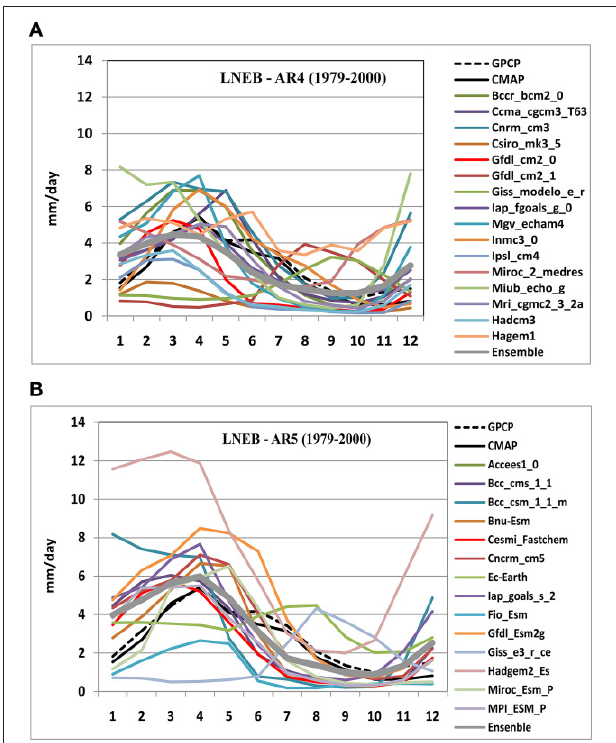
FIGURE 4 | Annual rainfall cycle observed (GPCP and CMAP) for the SNEB over the period 1979–2000 and simulated CMIP3-AR4 (A) CMIP5-AR4 (B)